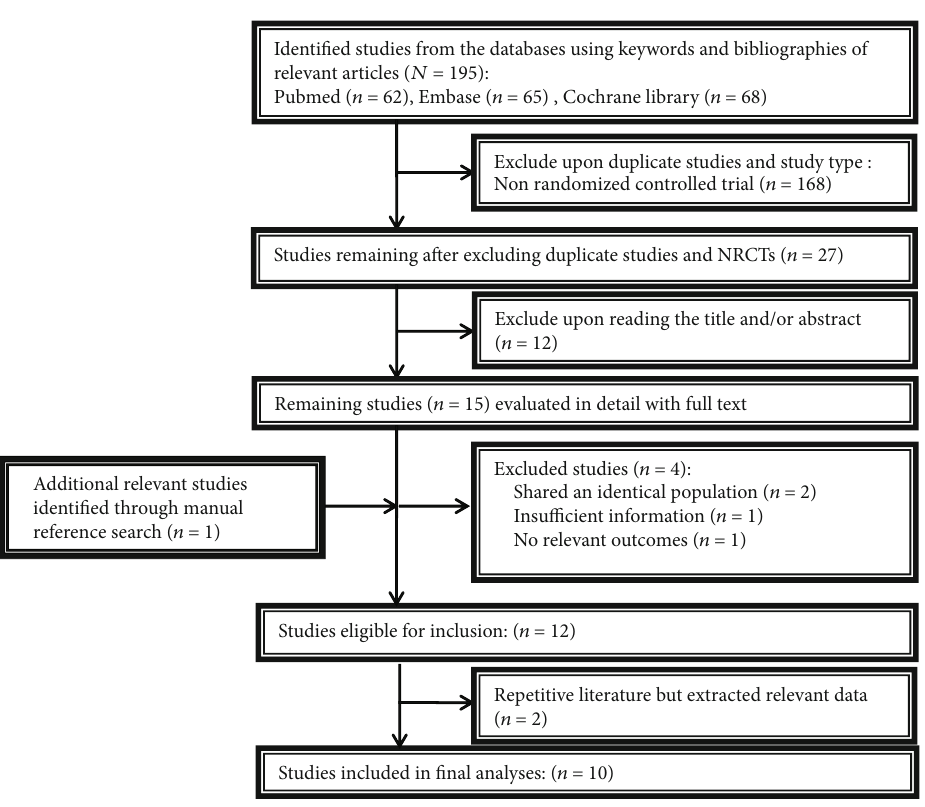
Figure 1: Flowchart of study